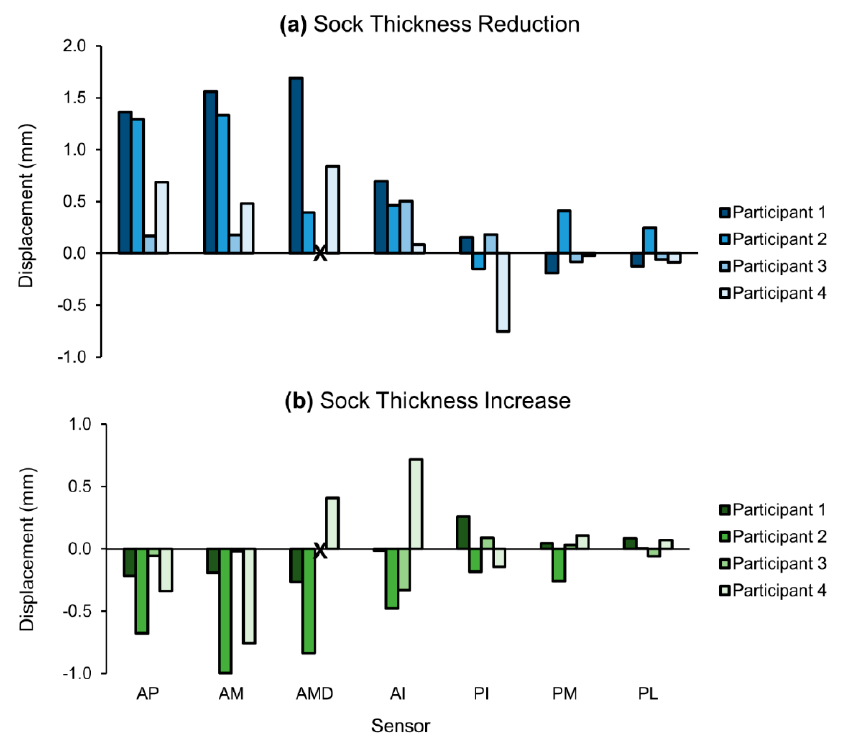
Figure 8. Changes in peak-to-peak limb–socket displacements for the following: ( a ) a reduction in sock thickness from intermediate; ( b ) an increase in sock thickness from intermediate. Displacements typically increased when sock thickness decreased and decreased when sock thickness increased. Participant 3 did not have an anterior midlimb distal sensor.